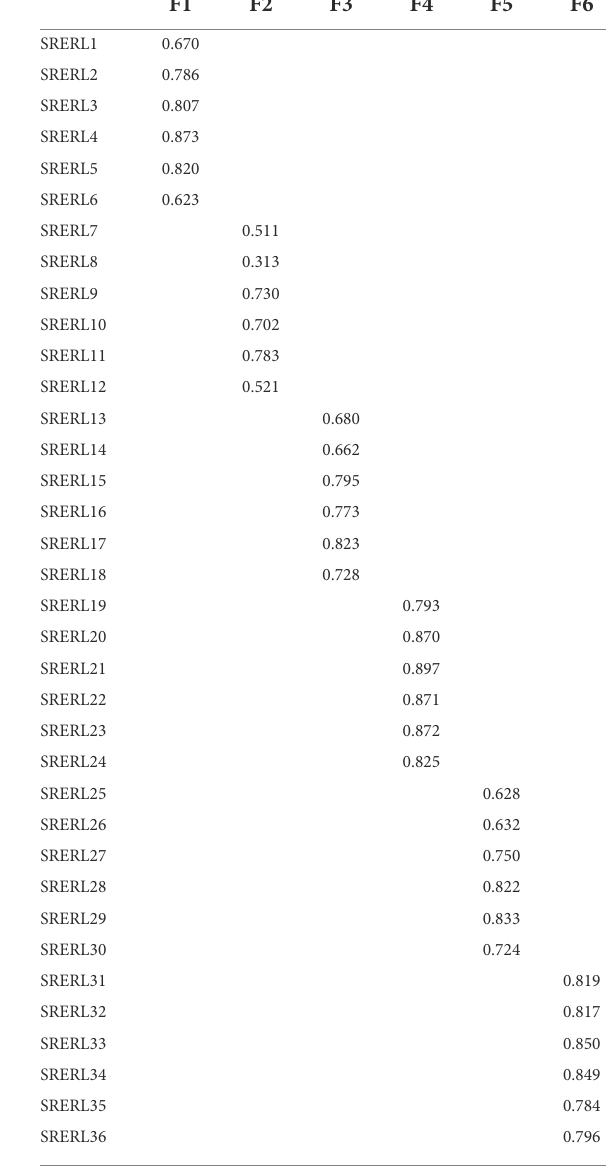
TABLE 6 Standardized total effects (default model; n = 840). TABLE 7 Standardized total effects (default model; n =